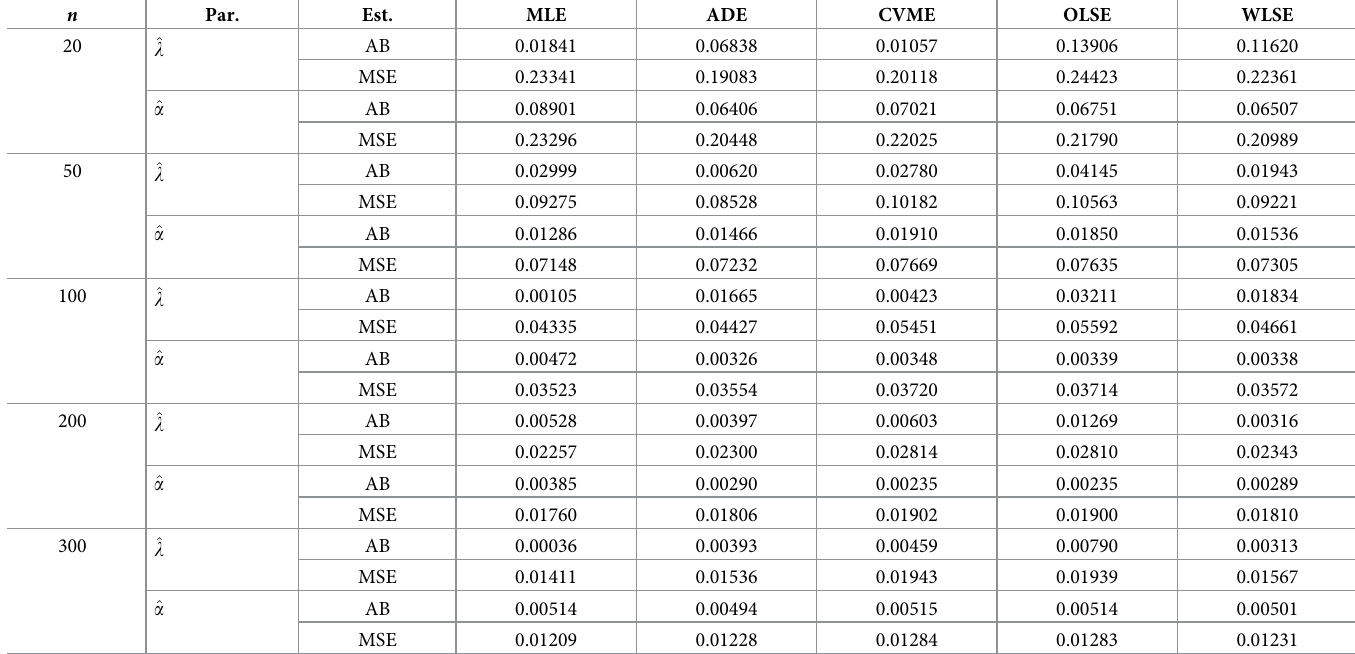
Table 5. Simulation results for ( λ = 0.5, α = 2.0). n Par.